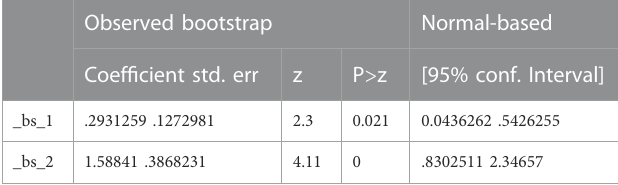
TABLE 6 Bootstrap test